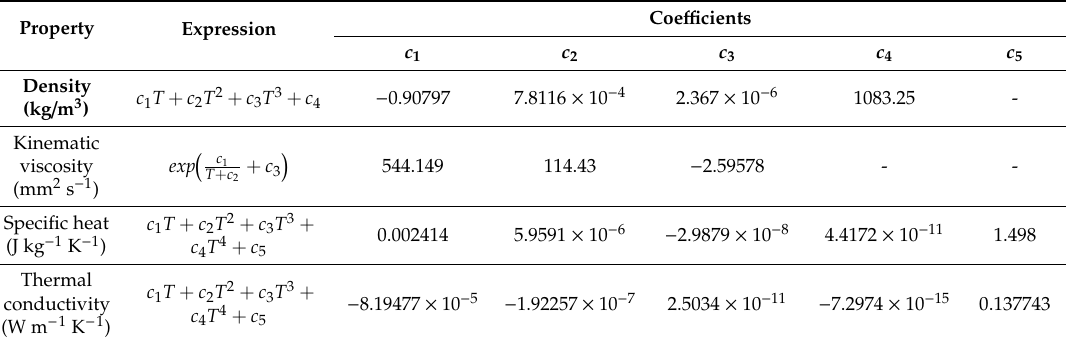
Table A1. Thermophysical properties of Therminol